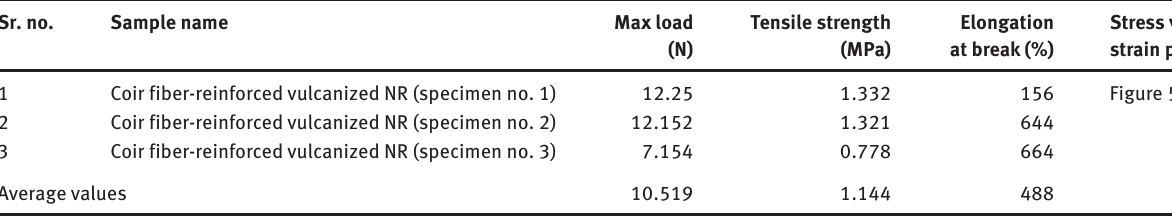
Table 3: Initial properties of coir fiber-reinforced vulcanized NR composite. Sr.